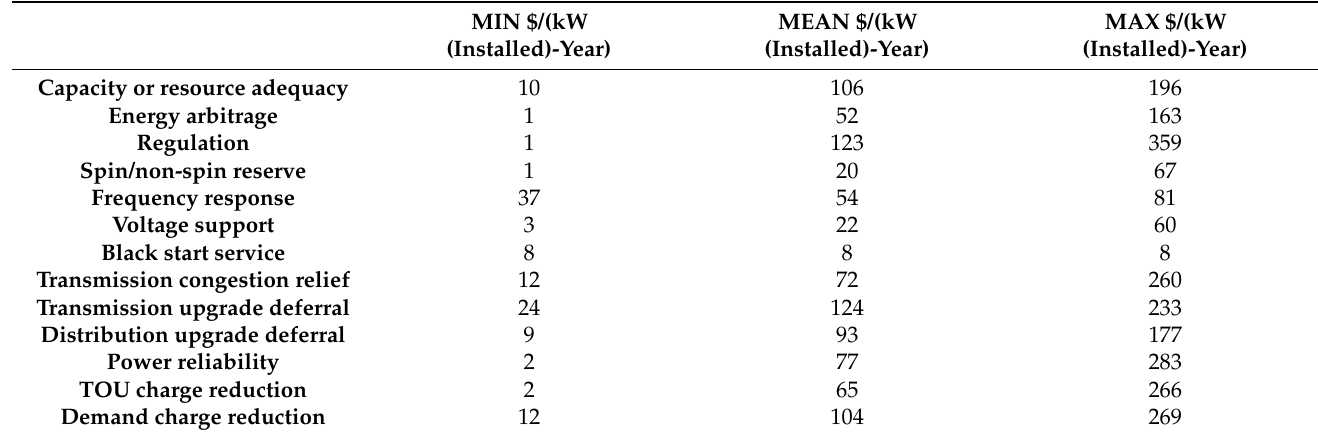
Table 4. Minimum, mean and maximum values of different applications in the US markets. Repro- duced from Ref.